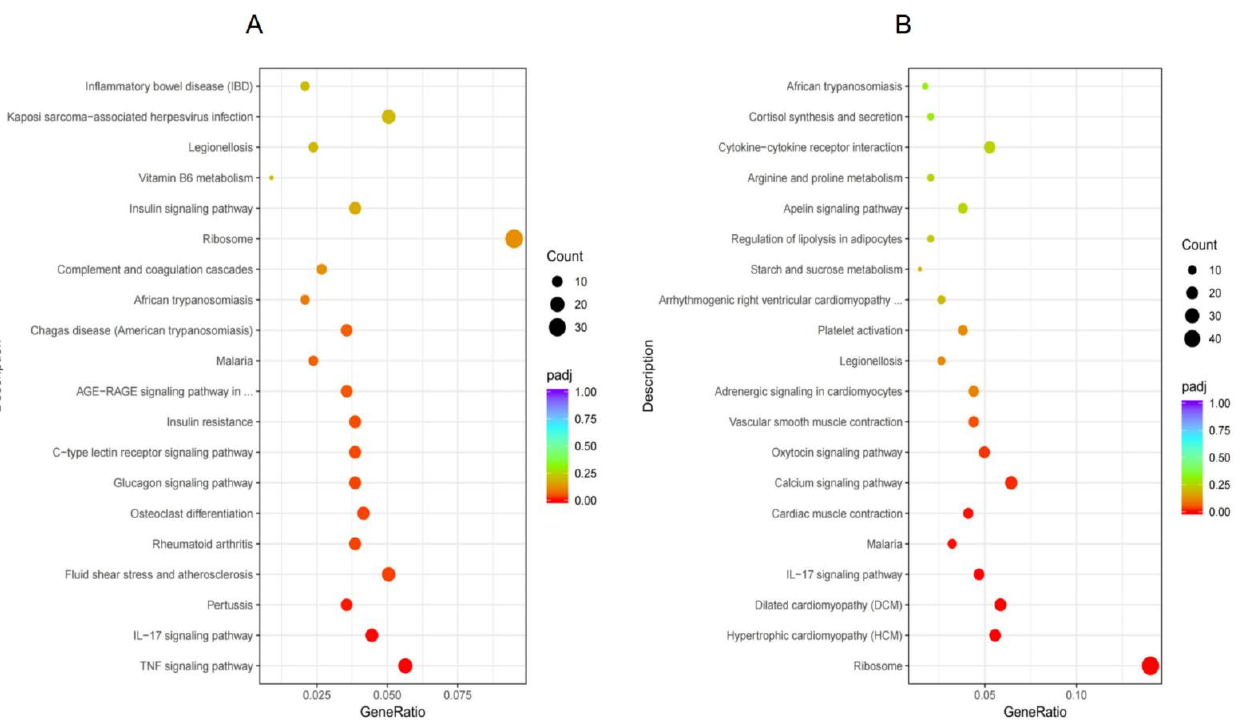
Figure 3. KEGG pathway enrichment analysis. The abscissa is the ratio of the number of differential genes annotated to the KEGG pathway to the total number of differential genes, and the ordinate is the KEGG pathway. ( A ): control vs IND, ( B ): IND vs MD-4. Table 3. Main genes involved in the six major enriched Kyoto Encyclopedia of Genes and Genomes pathways common to IND- and MD-4-treated